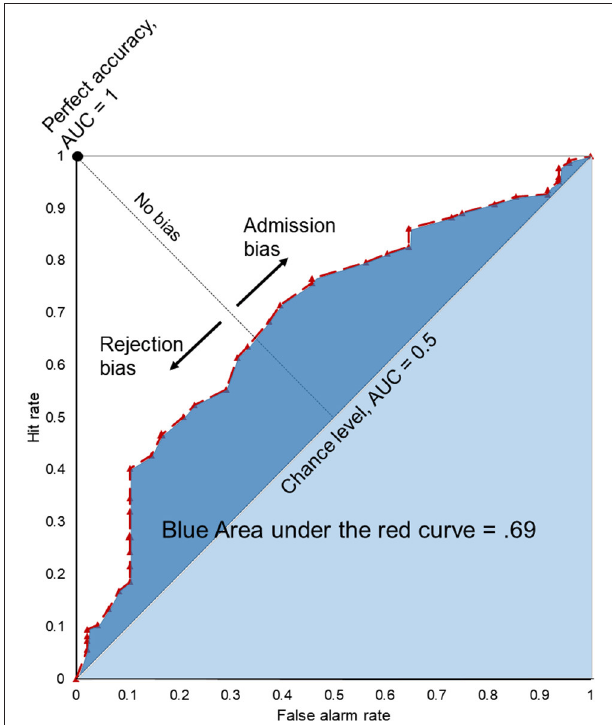
FIGURE 3 | The Receiver Operating Characteristic curve (ROC-curve) visualizes the accuracy of a predictor of academic success. The area under the curve (AUC), ranging from 0.5 to 1, quantifies the accuracy. Each applicant’s score on the predictor is compared to each possible criterion, in this case grades 4–8 in steps of 0.1 for SSGPA/ACS/NCS. Each criterion yields a false alarm rate and a hit rate for the sample of students, a data point in de the